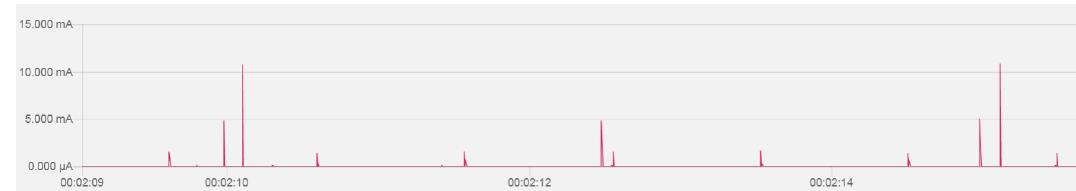
Figure 9. A typical cycle (5Hz) of tag current consumption, including five data samplings and data package sending.